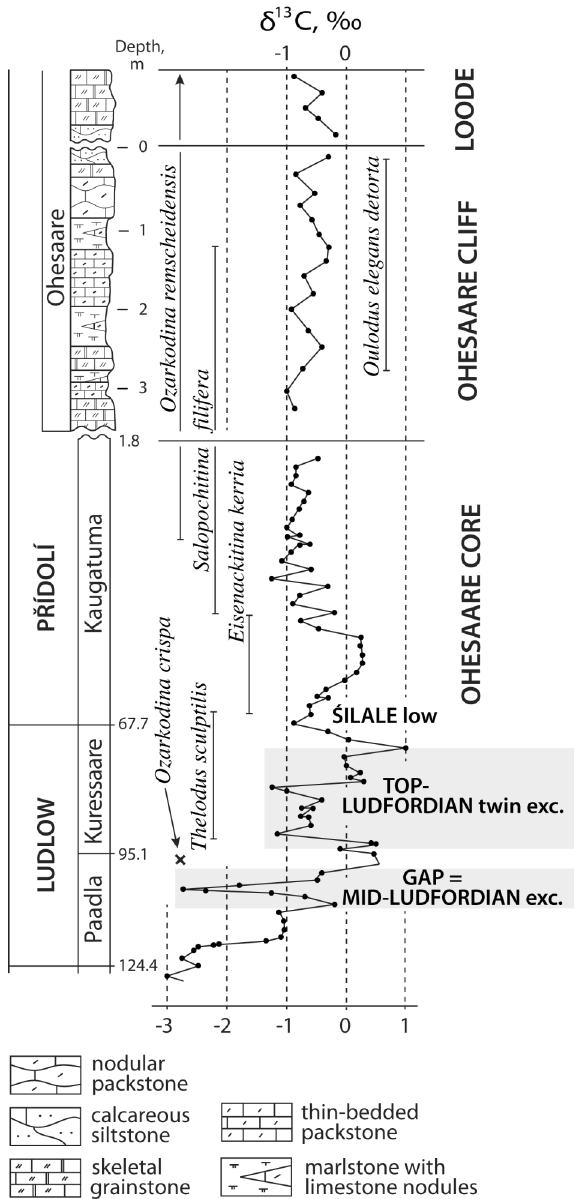
Fig. 7. Ludlow and P ř (cid:237)dol(cid:237) δ 13 C curve from the Ohesaare drill core, Ohesaare cliff section and Loode outcrop south of the cliff on the Sırve Peninsula. Note that calcareous siltstone beds in the top of the cliff and in the bottom of the outcrop are very similar. Conodont data from Viira (1999, 2000), chitinozoans from Nestor (2011) and vertebrates from M(cid:228)rss